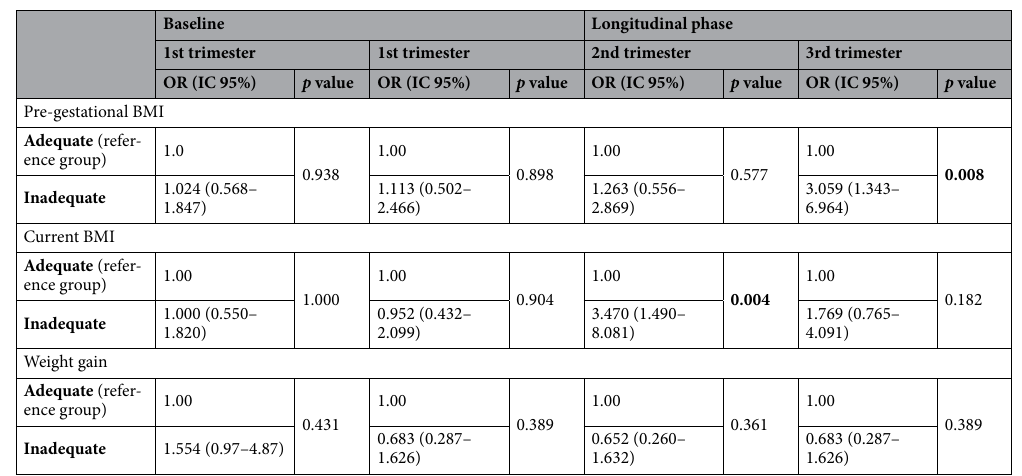
Table 4. Odds ratio (OR) for having > 1 h of social jetlag according to anthropometric variables categories in the gestational trimesters (reference group: ≤ 1 h of social jetlag). Logistic regressions analysis adjusted model for age, marital status, schooling, work (yes or no), parity and gestational age. Bold value is statistically significant at p < 0.05. IC confidence interval.